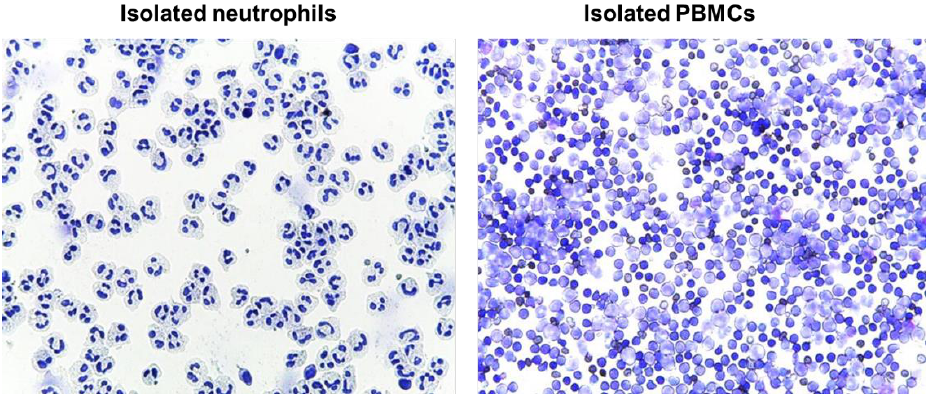
Figure 10. Representative cytospins from isolated human blood neutrophils ( left panel ) PBMCs ( right panel ). Images taken at 40 × and total PBMCs ( right panel ). Images taken at 40x magnification.